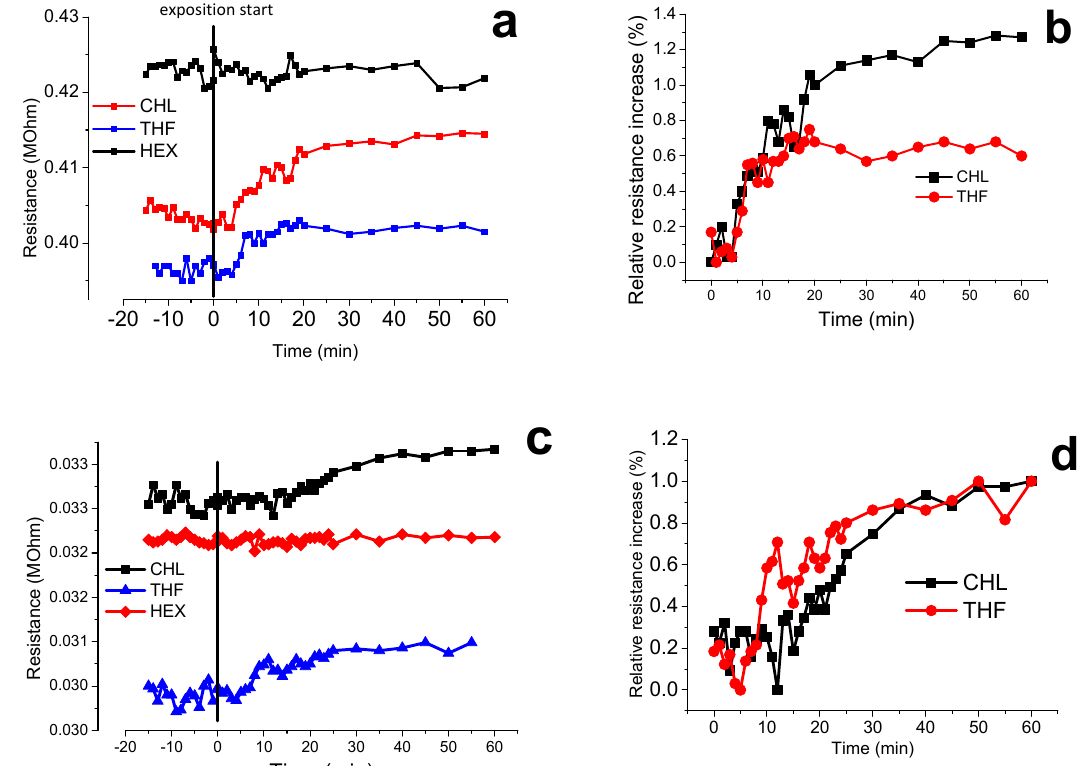
Figure 9. ( a ) Resistance of 7 wt.% MWCNTs/ TP9PYR(6) dispersion with the exposure time towards saturated atmospheres of chloroform, tetrahydrofuran and hexane for 1 h and ( b ) relative resistance variation (%) towards saturated atmosphere of chloroform and tetrahydrofuran; ( c ) the same of a) but testing 10 wt.% MWCNTs/ TP9PYR(6) dispersion; ( d ) the same of b) but testing 10 wt.% MWCNTs/TP9PYR(6) dispersion.